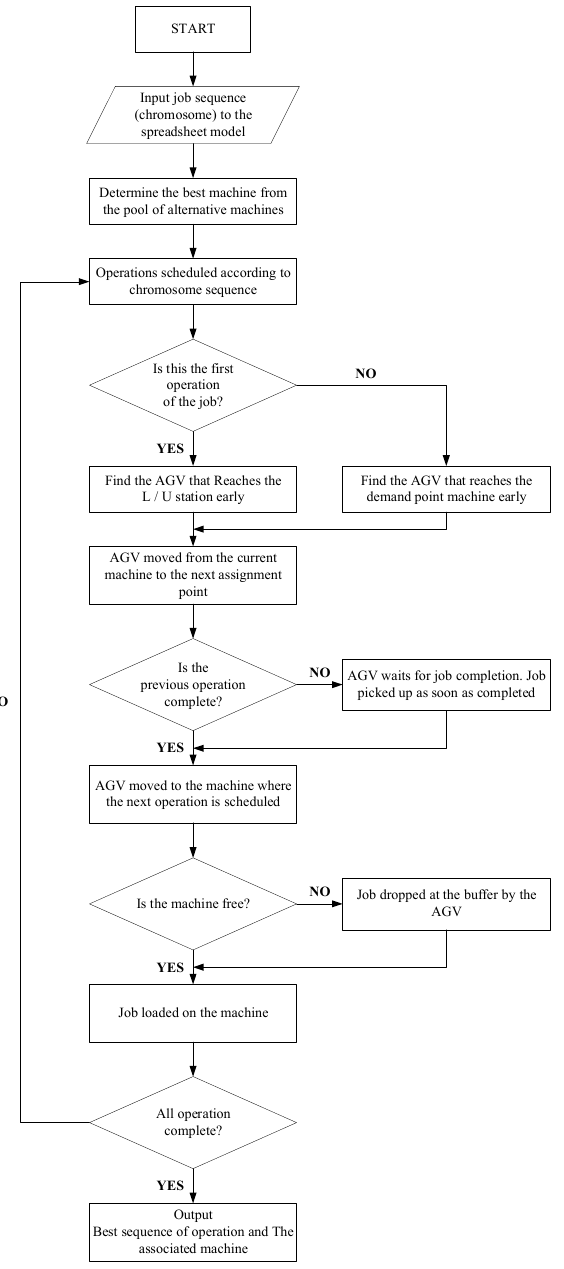
Fig. 5. AGV Assignment